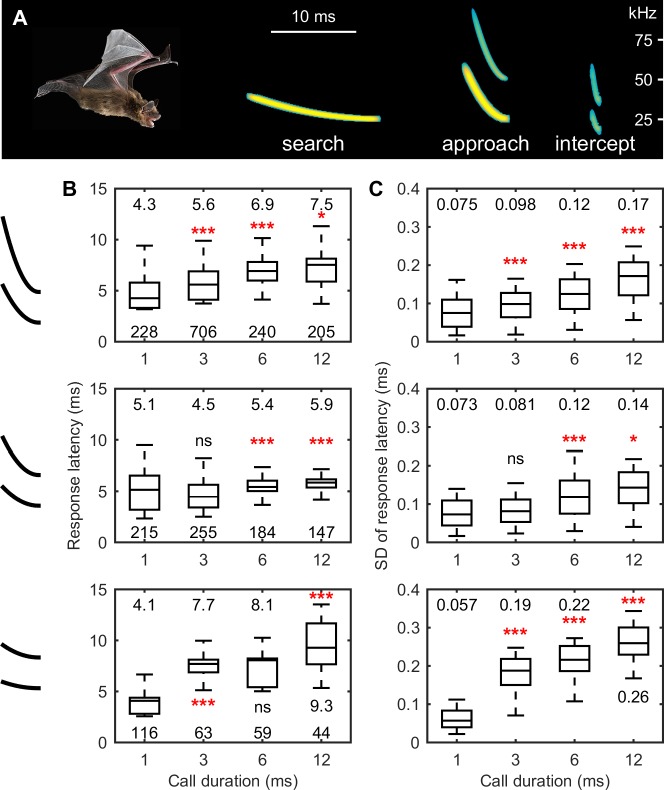
Functional correlates between EFP and bat sonar behavior.(A) Big brown bat dynamically adjusts the spectral–temporal structure of echolocation calls as it searches, approaches, and intercepts the prey. Echolocation calls were replotted from Moss and Surlykke (2001) [47]. (B, C) Echolocation calls of short duration and wide frequency range evoke EFPs of the highest temporal precision and shortest response latency. For each condition, the data were from the EFP sites whose temporal precision was among the top 50% and whose peaks were reliably detected for at least 90% of the trials. The number above each boxplot is the median, and the number below the boxplot in figure panel B is the number of recording sites (i.e., sample size). Statistical significance levels of the nonparametric rank sum test between the data group and the neighboring left data group are indicated by asterisks (P < 0.05*, P < 0.01**, P < 0.001***) or “ns” (P > 0.05). Of note, the same effects of call features on EFP properties can be seen in S2 Fig in which the EFPs from the same recording site were compared across signal durations. Data for this figure are included in S1 Data. The bat image in (A) is credited to B. Fenton and B. Falk. EFP, extracellular field potential.